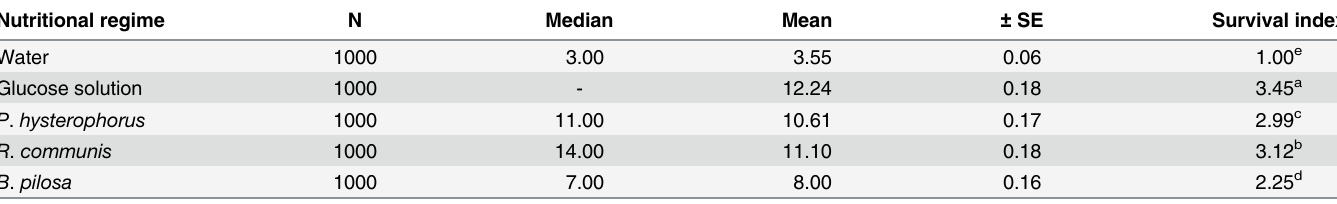
Table 1. Survival times in days of An . gambiae exposed to different nutritional regimes. Nutritional regime N Water Glucose